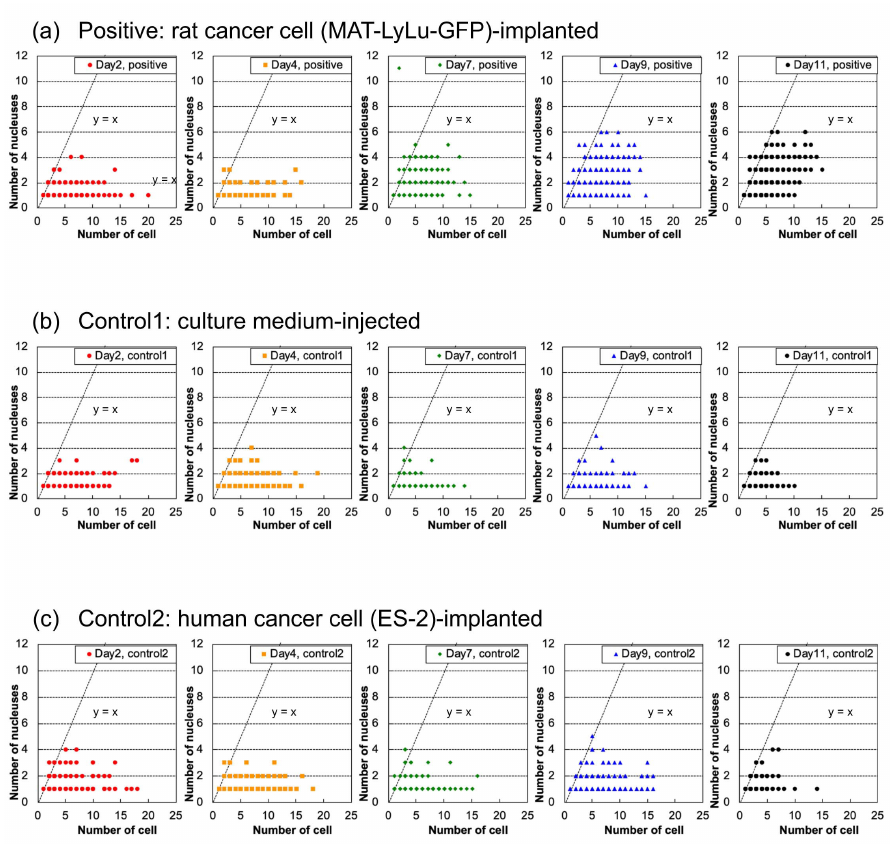
Figure 10. Time-course changes of cell number and nucleus number distribution in positive ( a ), control 1 ( b ), and control 2 ( c ) blood of the same samples as in Figure 4. The cell number–nucleus number distribution map indicates the results for 2, 4, 7, 9, and 11 days after the implantation of rat cancer cells ( a , positive), culture medium ( b , control 1), or human cancer cells ( c , control 2). Measurements were performed for six rats for positive cases and three for controls. The data for each sample are plotted as a dot in the graphs. The dashed line corresponding to y = x represents the relationship of single cell with a single